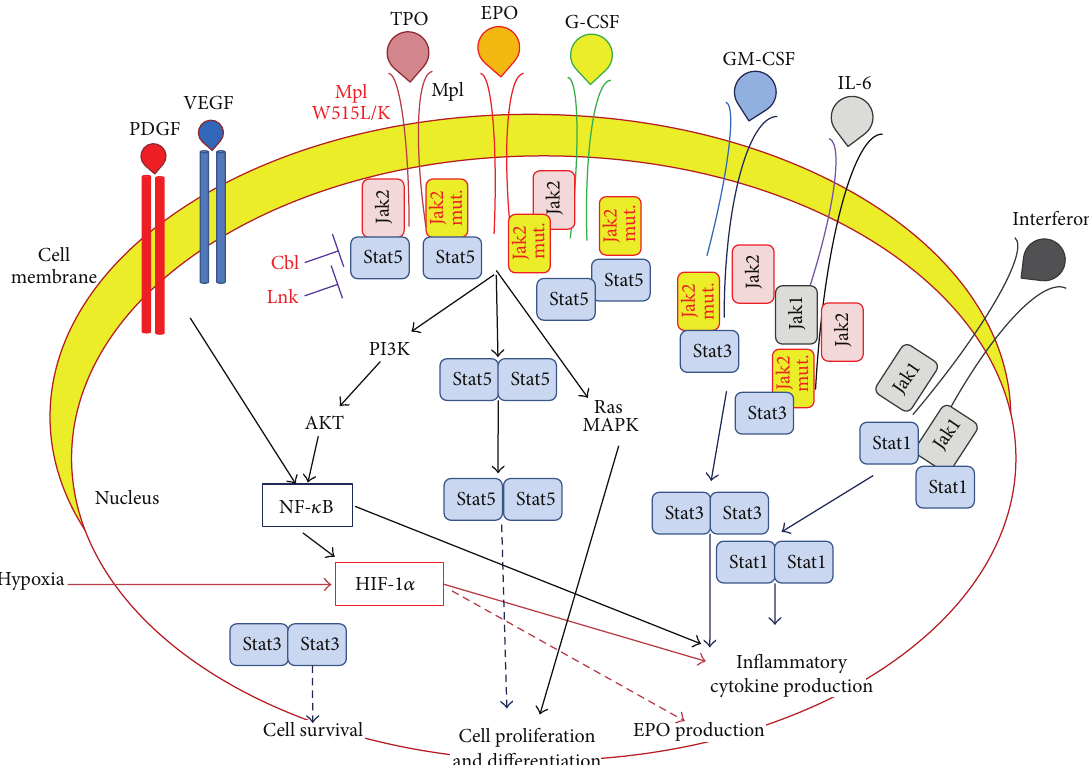
Figure 4: Molecular pathways activated by inflammatory cytokines and growth factors and affected by MPN-associated mutations. Most cytokine and growth factor receptors can activate the HIF-1 𝛼 , NF- 𝜅 B, and/or one or more of the different JAK/STAT pathways, either directly or indirectly. Among the JAK kinases, myeloid cells express essentially JAK2 and to a lesser degree JAK1 and TYK2 (not represented). JAK2 activates STAT5 and STAT3. JAK1 activates mainly STAT1 and to a lesser degree STAT3. The different STAT transcription factors form homodimers as well as heterodimers, which allows for a differential regulation of the expression of inflammatory cytokines. In MPN clonal cells, the JAK2-coupled receptors of EPO, TPO, and G-CSF may form complexes with and activate wild type JAK2 only, V617F- mutated JAK2 only, or wild type and V617F-mutated JAK2, which likely result in different levels of activation of the JAK2/STAT pathways concerned. Moreover, EPO, TPO, and G-CSF activate other molecular pathways besides the JAK/STAT pathways, such as the antiapoptosis, prosurvival PI3K/AKT pathway and the proproliferation RAS/MAPK pathway. Of note, activation of HIF-1 𝛼 leads to an increased production ofinflammatorycytokinesinallcelltypes,butHIF-1 𝛼 inducesEPOexpressiononlyintherareEPO-producingcelltypes(renalcells,neuronal cells, and certain tumors). LNK loss-of-function mutants result in enhanced activation of JAK2/STAT5. The CBL mutants detected in MPNs also enhance JAK/STAT signaling. Blue arrows represent JAK/STAT pathways, and red arrows represent HIF